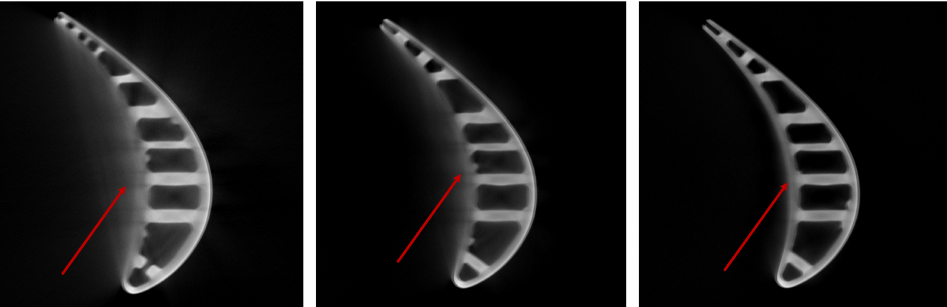
Figure 1. ICT images of turbine blades affected by different degrees of artifacts—the degree decreases from left to right. Severe artifacts have seriously affected the measurement of the wall thickness of blades in CT